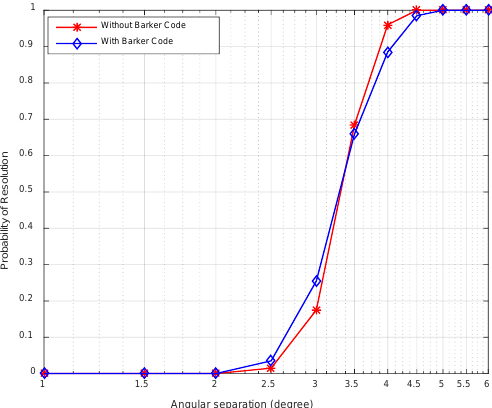
Figure 18. Resolution probability against the angular separation.